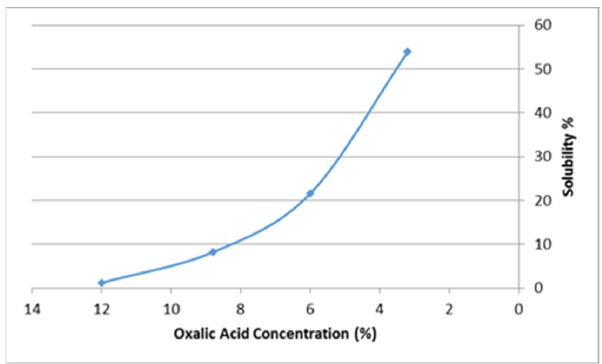
Figure 3. Solubility (%) versus % Oxalic acid at 50